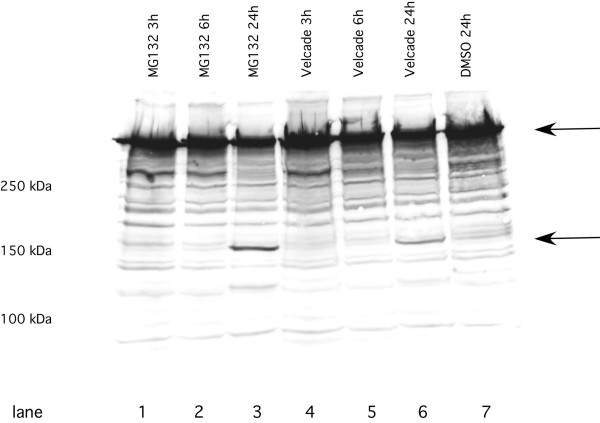
Degradation of DNA-PKcs by caspase-3 is a late event in apoptosis induced by proteasome inhibition in PC-3 cells. Representative (n = 3) western blot of lysates from PC-3 prostate cancer cells after 3, 6 and 24 hours incubation with MG-132 (50 μM) or Velcade (100 nM) using a specific antibody against human DNA-PKcs. The antibody recognizes the intact 460 kDa protein as well as the specific 160 kDa fragment observed after caspase-3 dependent cleavage of DNA-PKcs. MG-132 caused no significant change of the DNA-PKcs protein levels over a period of 6 hours. Detection of a caspase-3-cleavage specific 160 kDa fragment coincided with apoptosis at 24 hours, but did not occur during the first 6 hours.